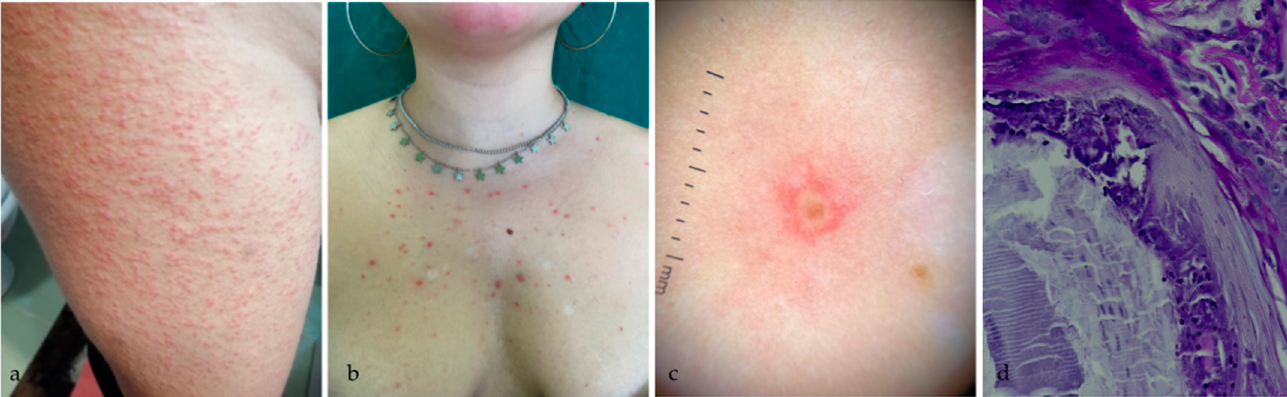
Figure 1. ( a ) First rash: plethora of erythematous pinhead-sized papular lesions, many of which were centered by follicular pustules; ( b ) second rash: papulopustular lesions involving d é collet é with hy- popigmented macules and patches of pityriasis Versicolor; ( c ) Dermoscopy (10 × ) of a folliculocentric pustule with surrounding erythema; ( d ) PAS (40 × ) re-vealed spherical to oval yeast-like